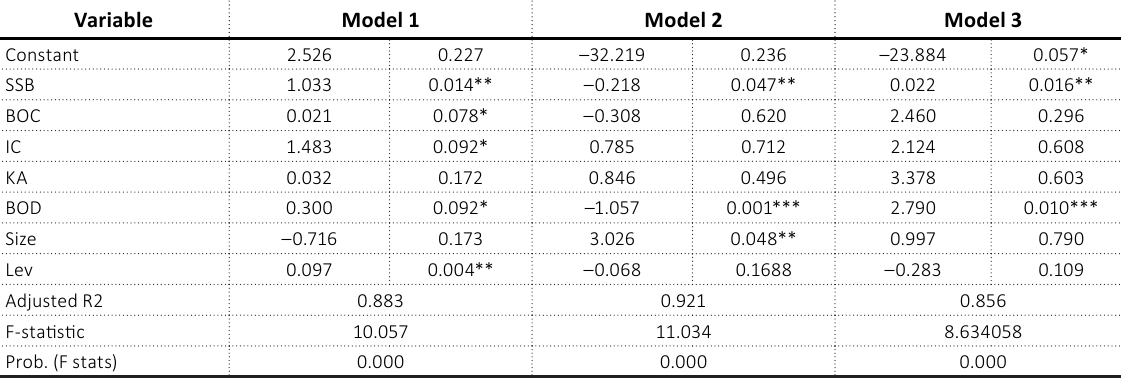
Table 3. Estimation results for all